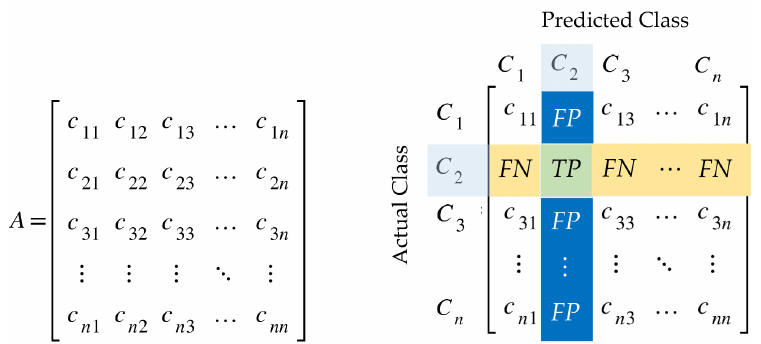
Figure 5. Confusion matrix for a multiclass classification